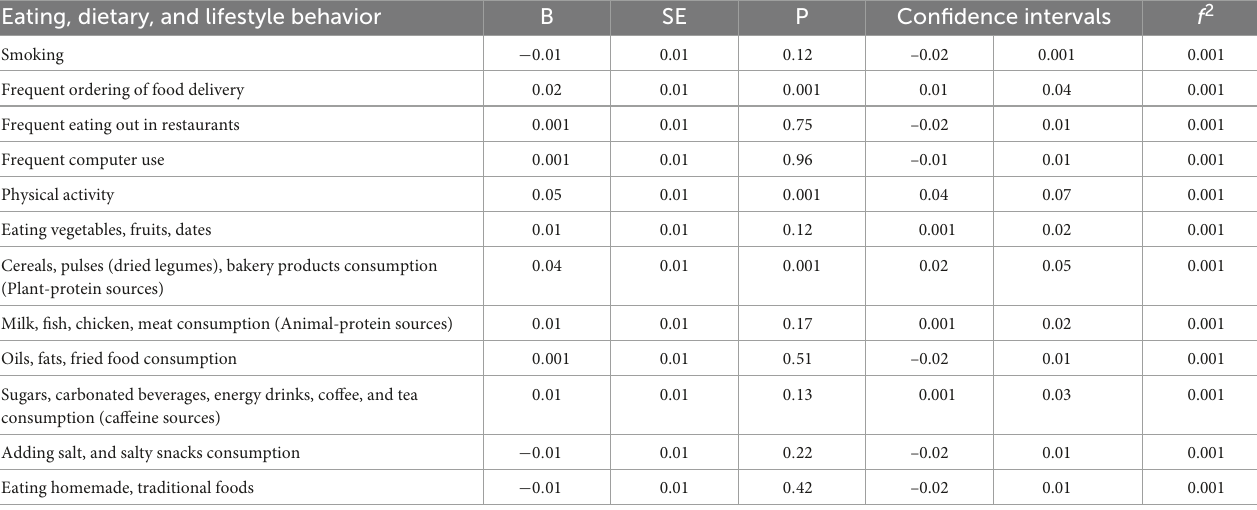
TABLE 4 Associations between dietary and lifestyle behavior modifications and reported sleep duration ( N = 24,541). Eating, dietary, and lifestyle behavior